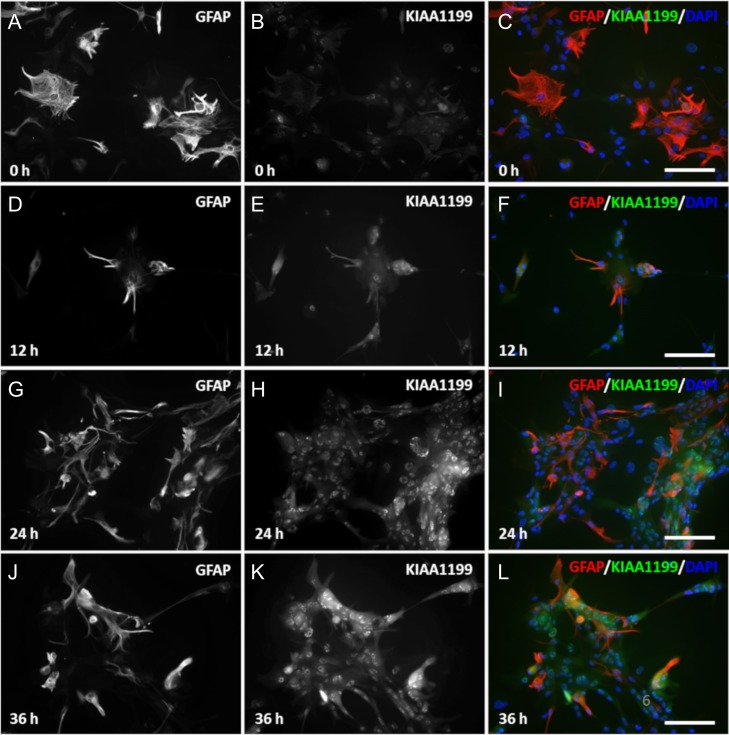
Primary mouse astrocytes incubated with a cytokine mix for 0, 12, 24 and 36 h were labeled for GFAP (A, D, G, J) and KIAA1199 (B, E, H, K). (C), (F), (I) and (L) are the merged micrographs that display KIAA1199 (green), GFAP (red) and the DAPI counterstain (blue). KIAA1199 expression was induced by the inflammatory cytokines in a time-dependent manner (scale bar, 50 μm).